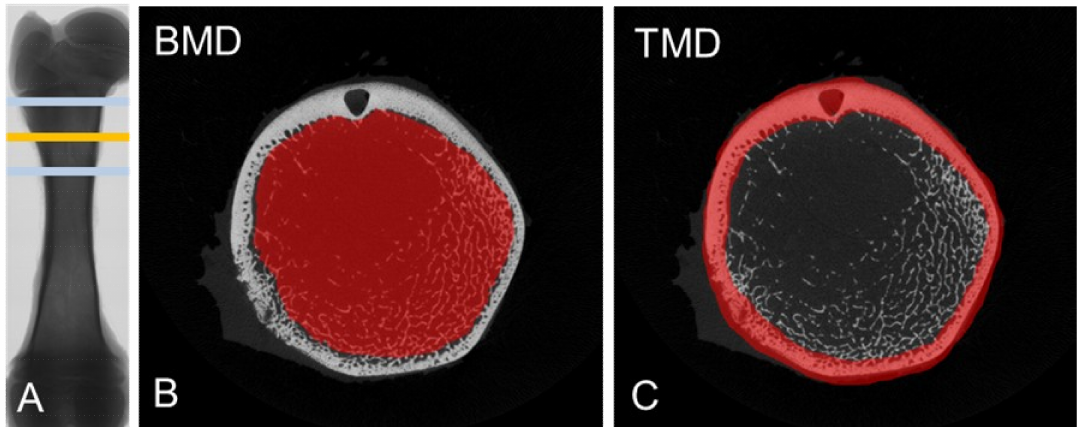
Figure 1. Representative images obtained from micro-CT analyses of porcine femurs. ( A ). The volume of interest (VOI) was set distal to the hip joint at 30% of the total femur length (yellow line) and covered 800 slices (light blue lines). ( B ). Region of interest (ROI) (red) represents the trabecular bone for measurements of bone mineral density (BMD). ( C ). ROI (red) to approximate the tissue mineral density (TMD) in cortical